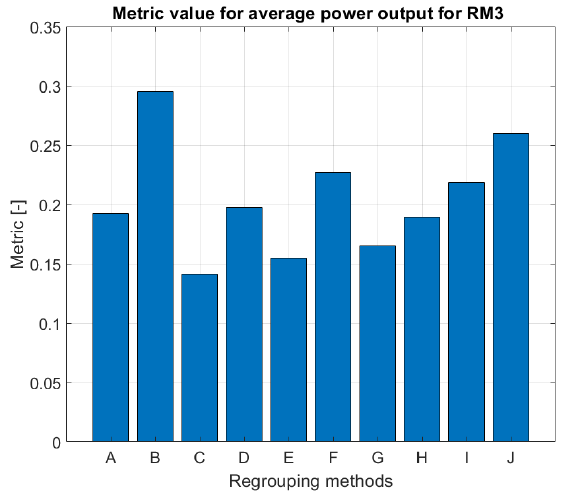
Fig. 11. Power output of a representative sea state of method C